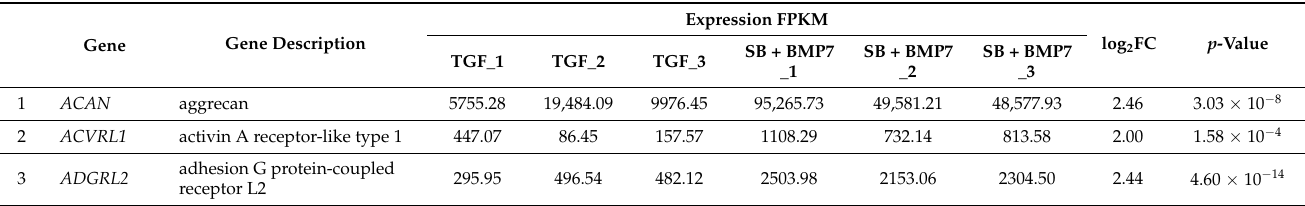
Table 3. 114 genes among ECM and cell surface molecules were upregulated by SB431542 and BMP7